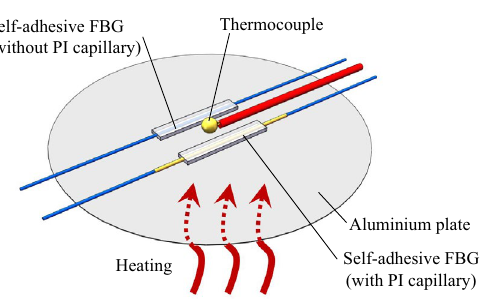
Figure 7. Experimental evaluation of the temperature response of the self-adhesive FBG sensors with and without PI